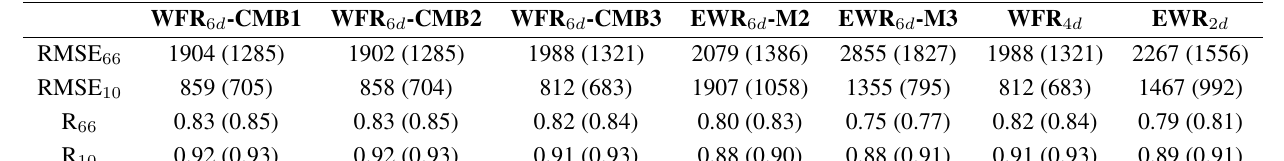
Table 2. Summary of resulting statistics of the spatial root-mean-squared error (RMSE, km 2 ) and spatial correlation coefficient (R) of polynya area for the complete set of 66 case studies (RMSE /R ) and a 10-day subset of almost constant clear-sky conditions 66 66 (RMSE /R ). Results are shown for the weighted ± 3-day time interval WFR 10 10 feature reconstruction (WFR)) based on our three “best fit” combinations (CMB1-CMB3) and three comparison runs comprising the weighted ± 2-day time interval (WFR as equally-weighted reconstruction runs based on a ± 3- and a ± 1-day time interval (EWR and EWR ). EWR is shown based on a minimum threshold of two (M2) or three days 2 d 6 d (M3) with polynya area (POLA). Numbers in parenthesis indicate the reconstruction results for an only partially-introduced cloud cover (about 50% of the sea-ice area).